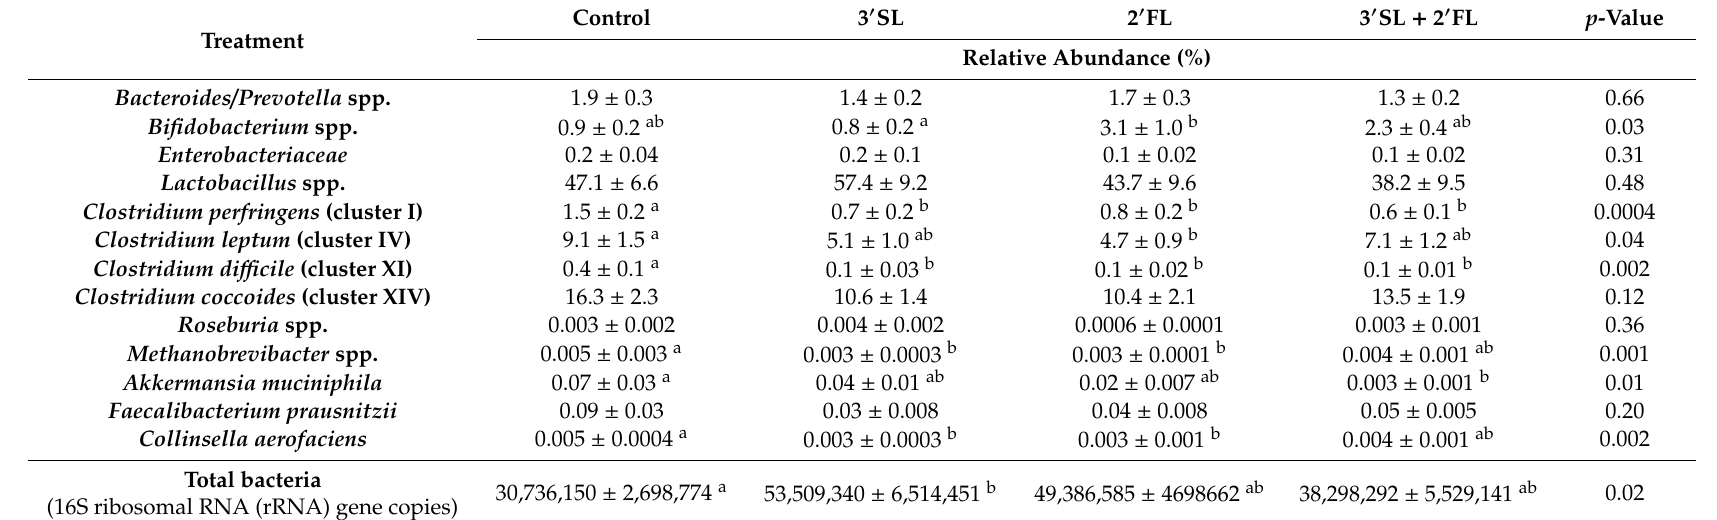
Table 1. Relative abundance of fecal microbiota (qPCR) in male rats at seven weeks of age fed the AIN-93 diet fortified with 3 (cid:48) SL, 2 (cid:48) FL, both, or neither. Control Treatment Relative Abundance (%) Bacteroides / Prevotella